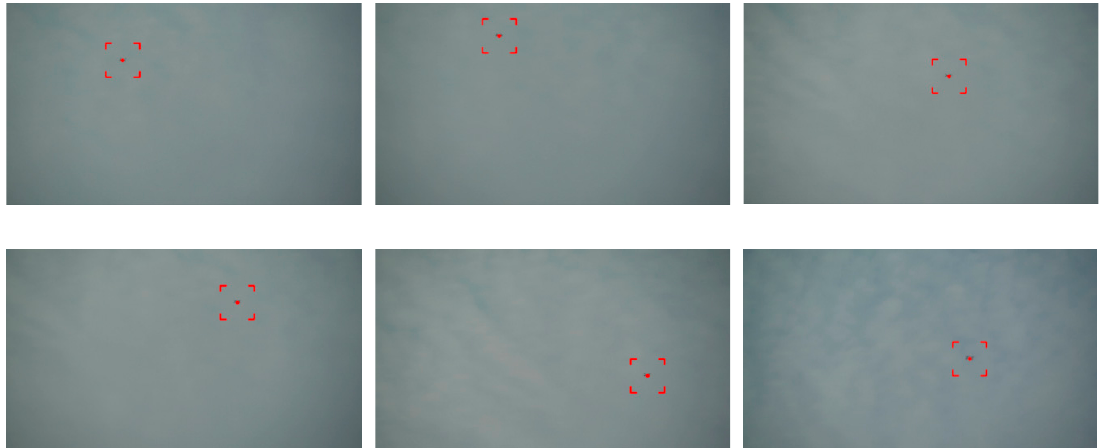
Figure 15. Results of the tracing test on cloudy days (drone flight altitude is 130 m).